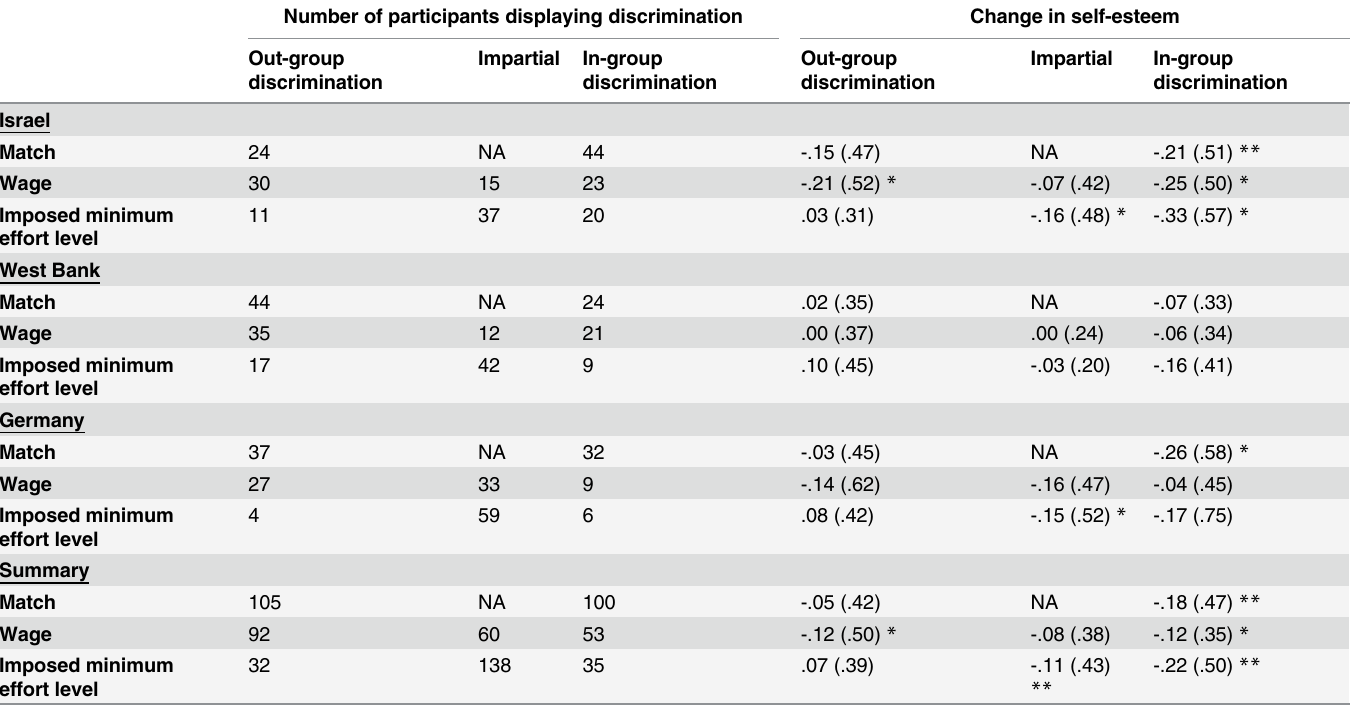
Table 2. Ethnicity-based discrimination: Frequency of discrimination, and changes in self-esteem according to